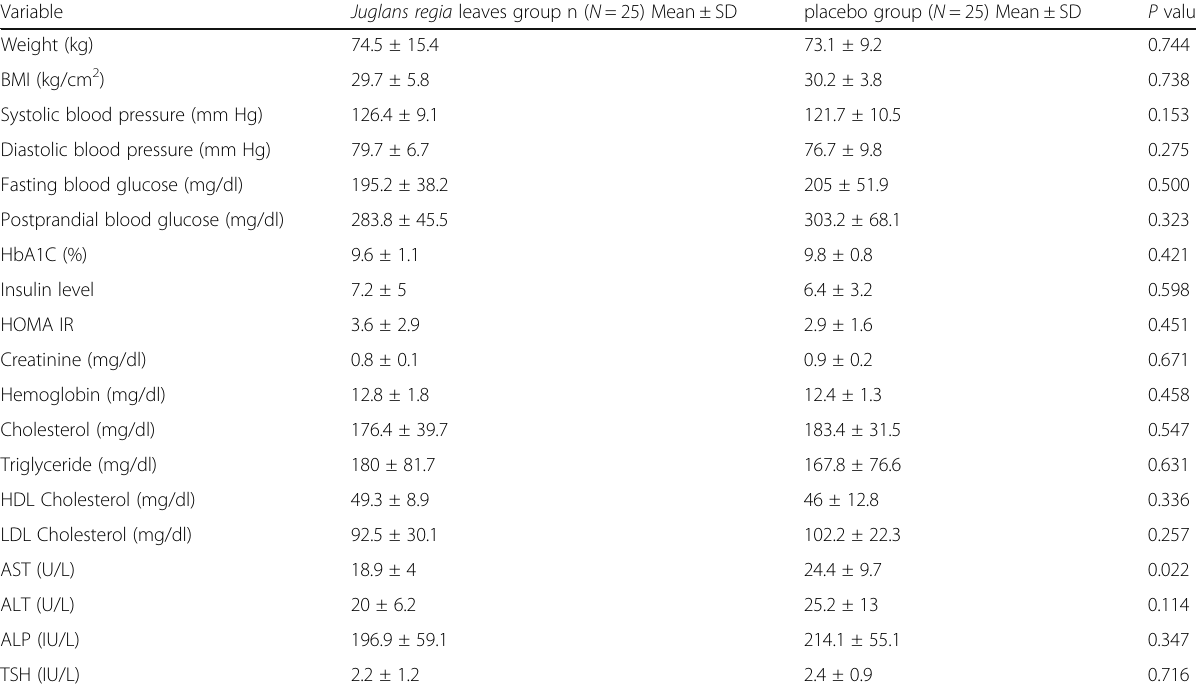
Table 1 Baseline participant data in two arms, Juglans regia leaves group and control group ( n = 50)